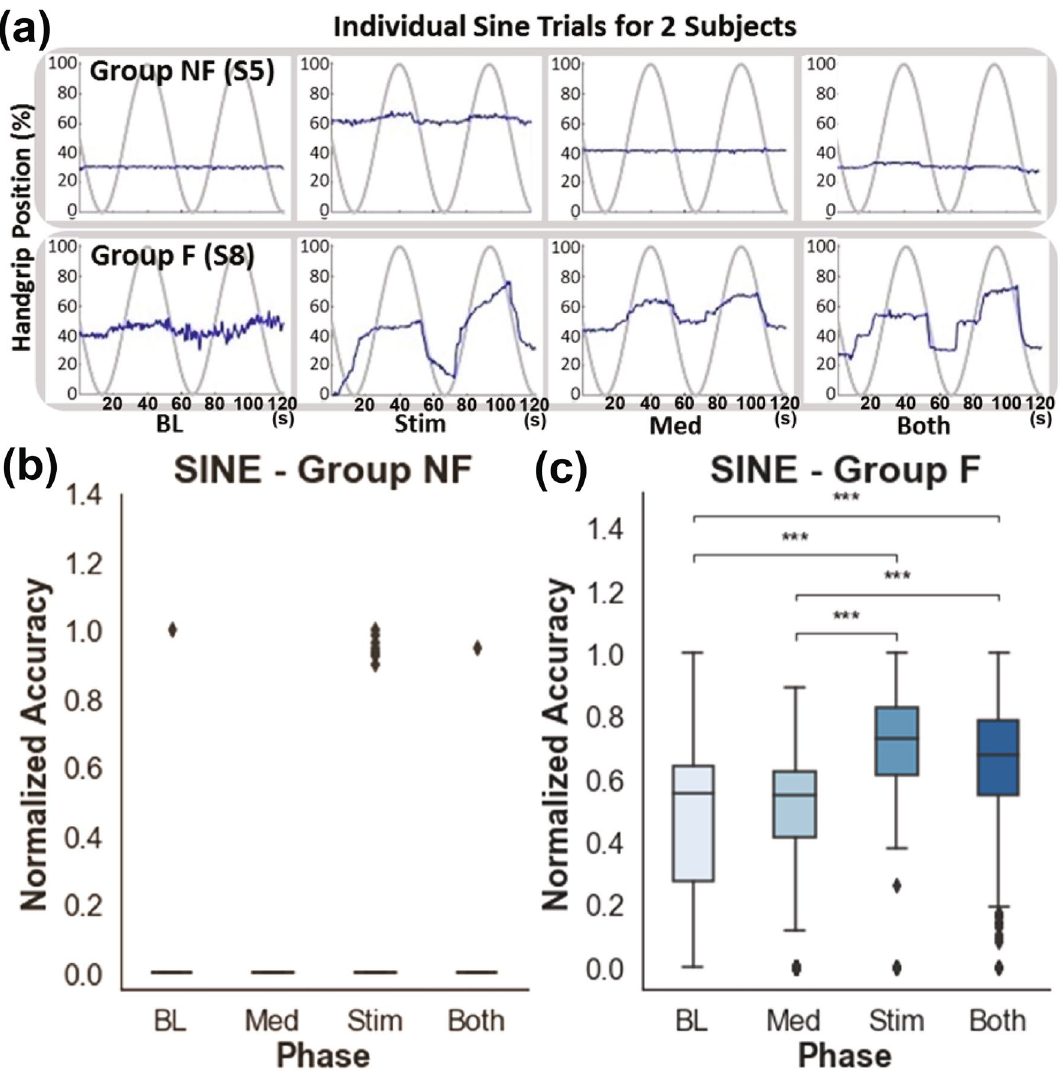
Figure 4. The performance of the SINE test in Group F and NF. ( a ) Representative results of SINE testing from two subjects, one from each group (Group F: S8 and Group NF S5). ( b , c ) Normalized sine scores for Group NF and Group F, respectively (n = 5 for each group). The number of asterisks indicates the threshold significance level detected by the three-way ANOVA; *: P < 0.05, **: P < 0.01, and ***: P < 0.001. The means and the standard deviation (SD) are